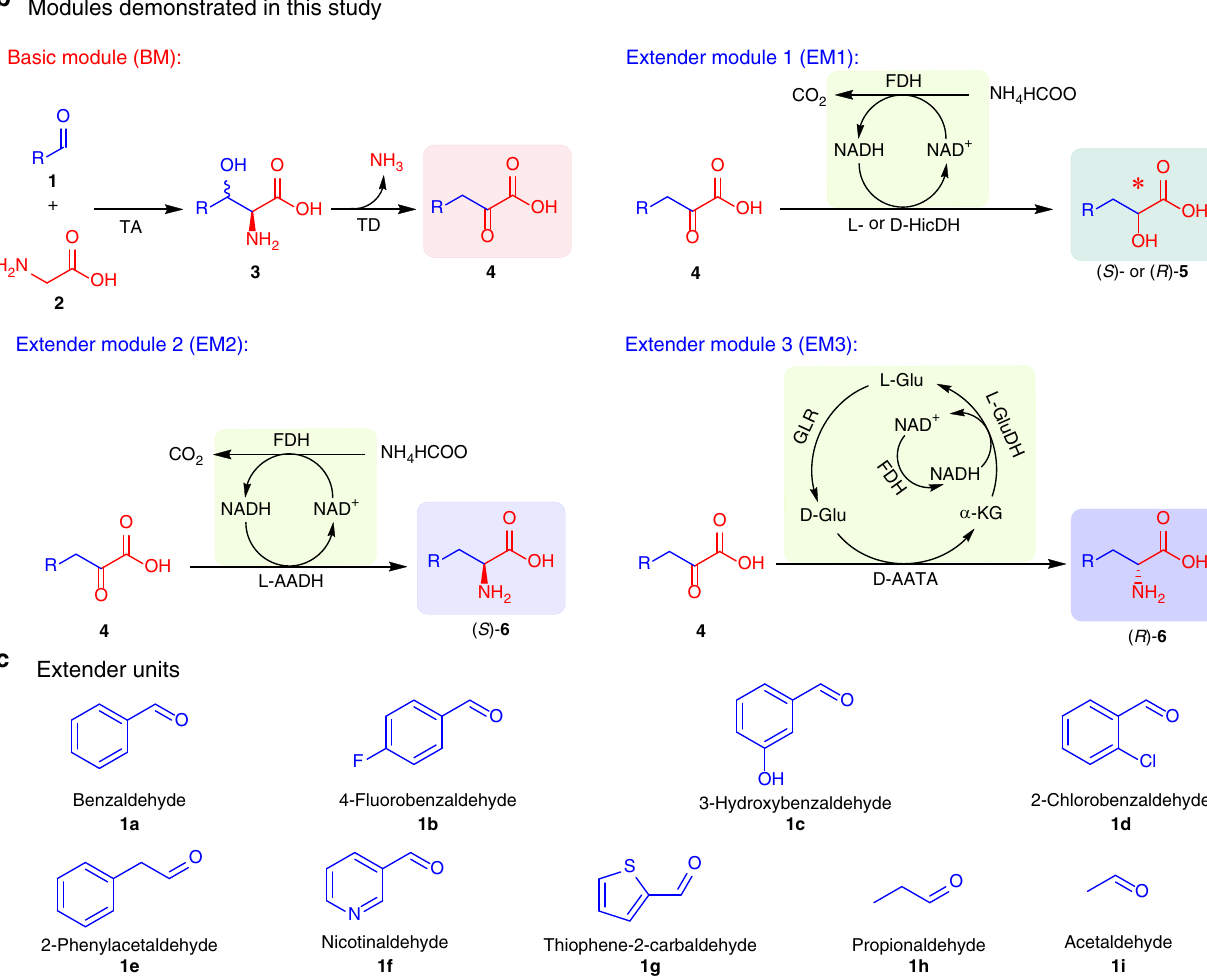
Fig. 1 The synthesis of α -functionalized organic acids by proposed modular cascade biocatalysis platform. a The engineered modular cascade biocatalysis platform. b Four general basic enzyme modules. Basic module: threonine aldolase (TA) and threonine deaminase (TD) for condensation-deamination of aldehydes and glycine to α -keto acids; extender module 1: hydroxyisocaproate dehydrogenase (HicDH) and formate dehydrogenase (FDH) for reduction of α -keto acids to α -hydroxy acid; extender module 2: ʟ -amino acid dehydrogenase ( ʟ -AAD) and FDH for reduction of α -keto acids to ʟ - α -amino acids; extender module 3: D -amino acid transaminase ( D -AATA), FDH, glutamate racemase (GLR), and glutamate dehydrogenase (GluDH) for transamination of α -keto acids to D - α -amino acids. Functionalized groups ( α -position) and extender units (from aldehydes) are colored in red and blue, respectively. c Nine different extender units, including aromatic ( 1a – e ), heteroaromatic ( 1f ), heterocyclic ( 1g ), and aliphatic ( 1h – i )